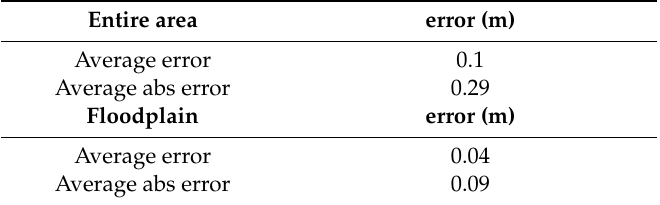
Table 4. The errors of the elevation on the computational grid compared to the original topographical point data with 10 m point spacing.